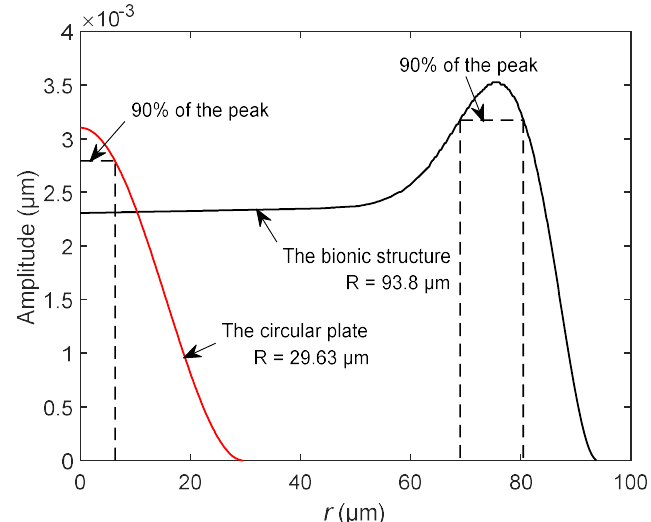
Figure 14. The comparison of vibration amplitudes between the circular plate and the bionic structure for the case of the same natural frequency.